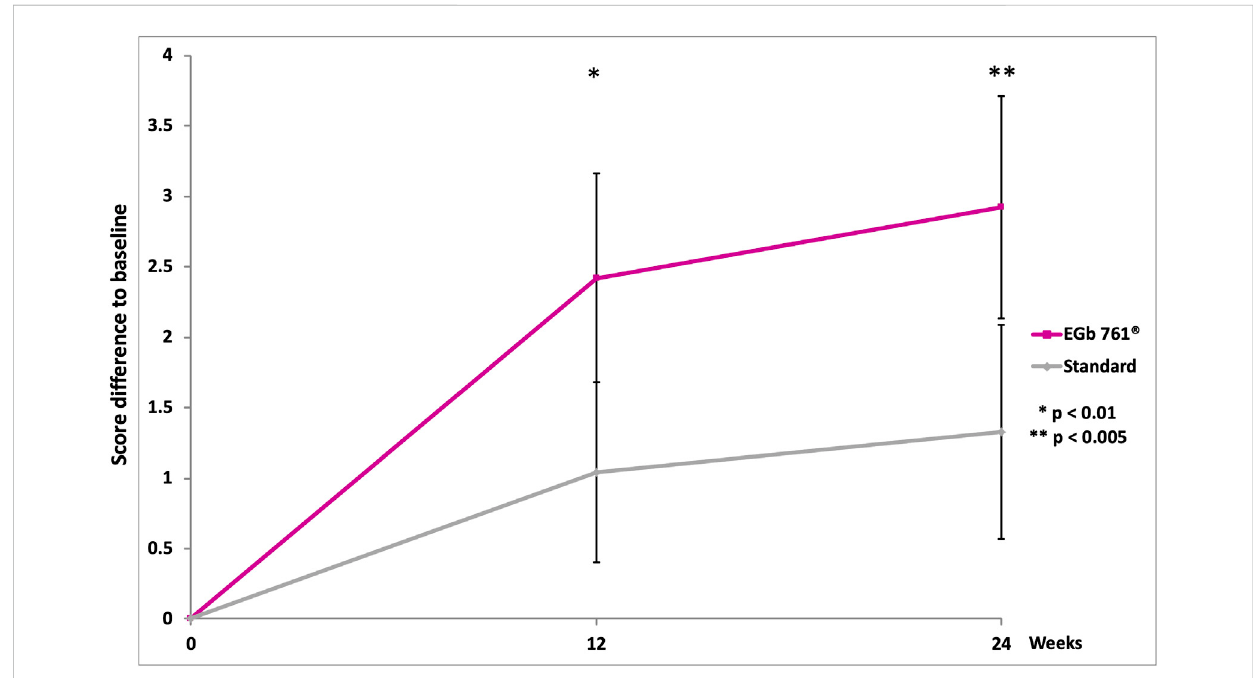
FIGURE 2 Change in Montreal Cognitive Assessment (MoCA) scores over the course of the study (means, 95% con fi dence intervals, two-sided p -values of t -test for between-group differences).